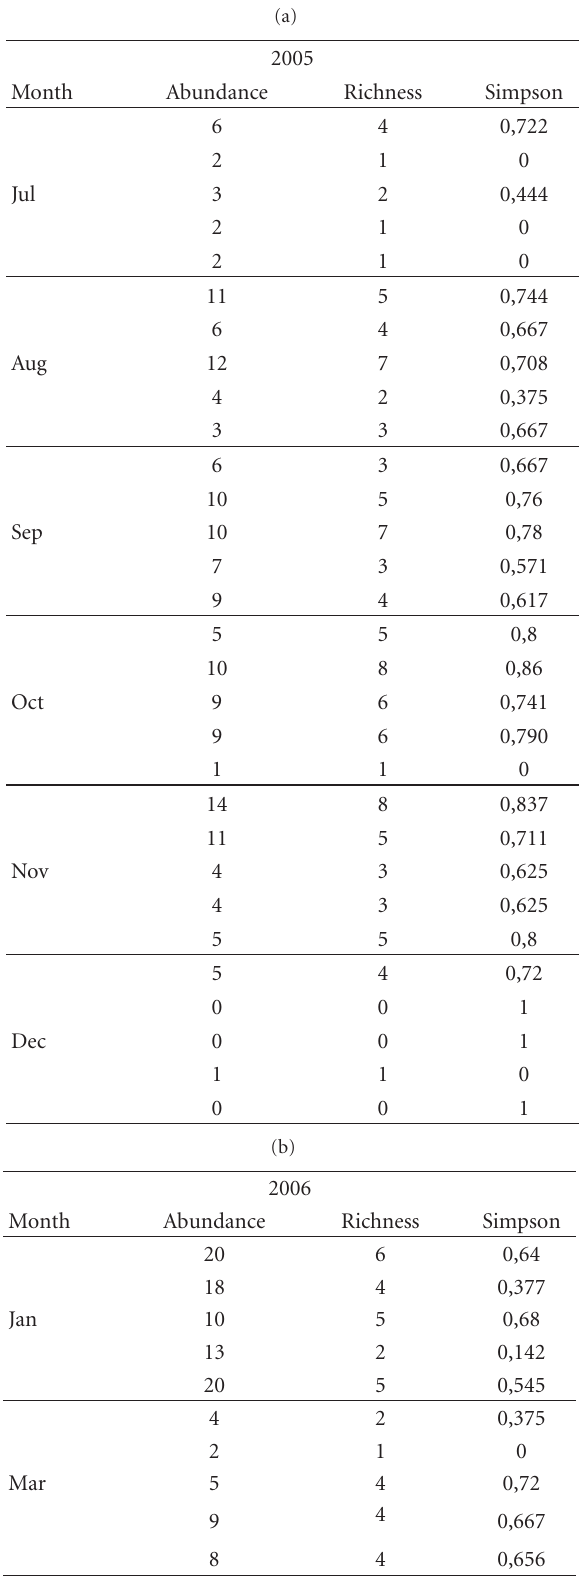
Table 4: Abundance, richness, and Simpson index of the species collected with five Escolitideo/Curitiba traps from July 2005 to July